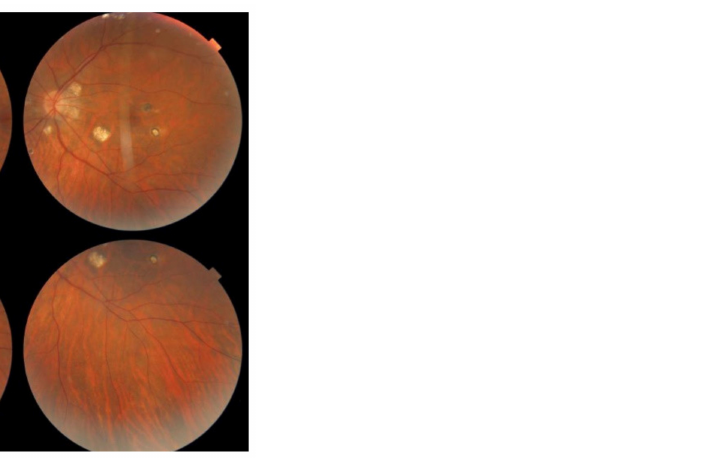
Figure 13. Idiopathic Multifocal choroiditis (MFC), fundus image. Multiple yellow foci typically seen in MFC (healed stage).